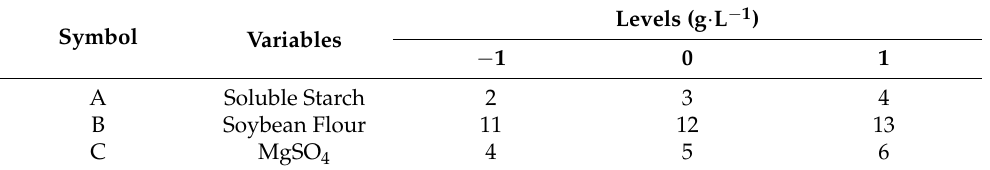
Table 1. Experimental factors with three levels.